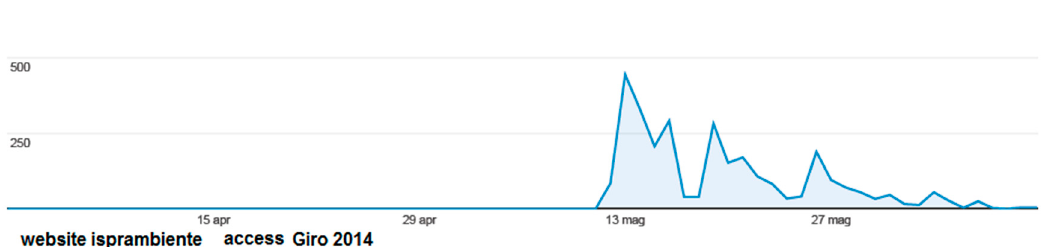
Figure 9. The picture shows the number of times the ISPRA institutional website was accessed, referring to the 3D videos of the Giro d’Italia 2014 and the related information, published contemporariously with the race.